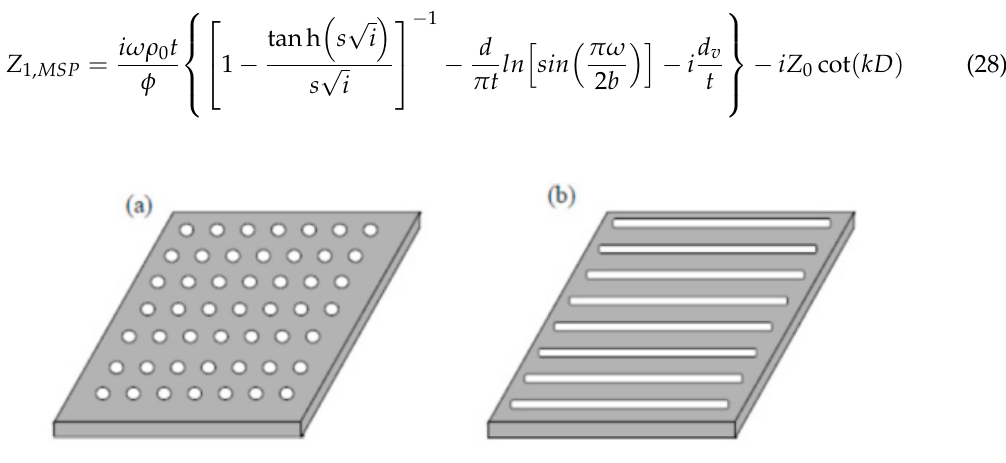
Figure 14. Sketch of a panel microperforated with ( a ) circular holes and ( b ) slits.